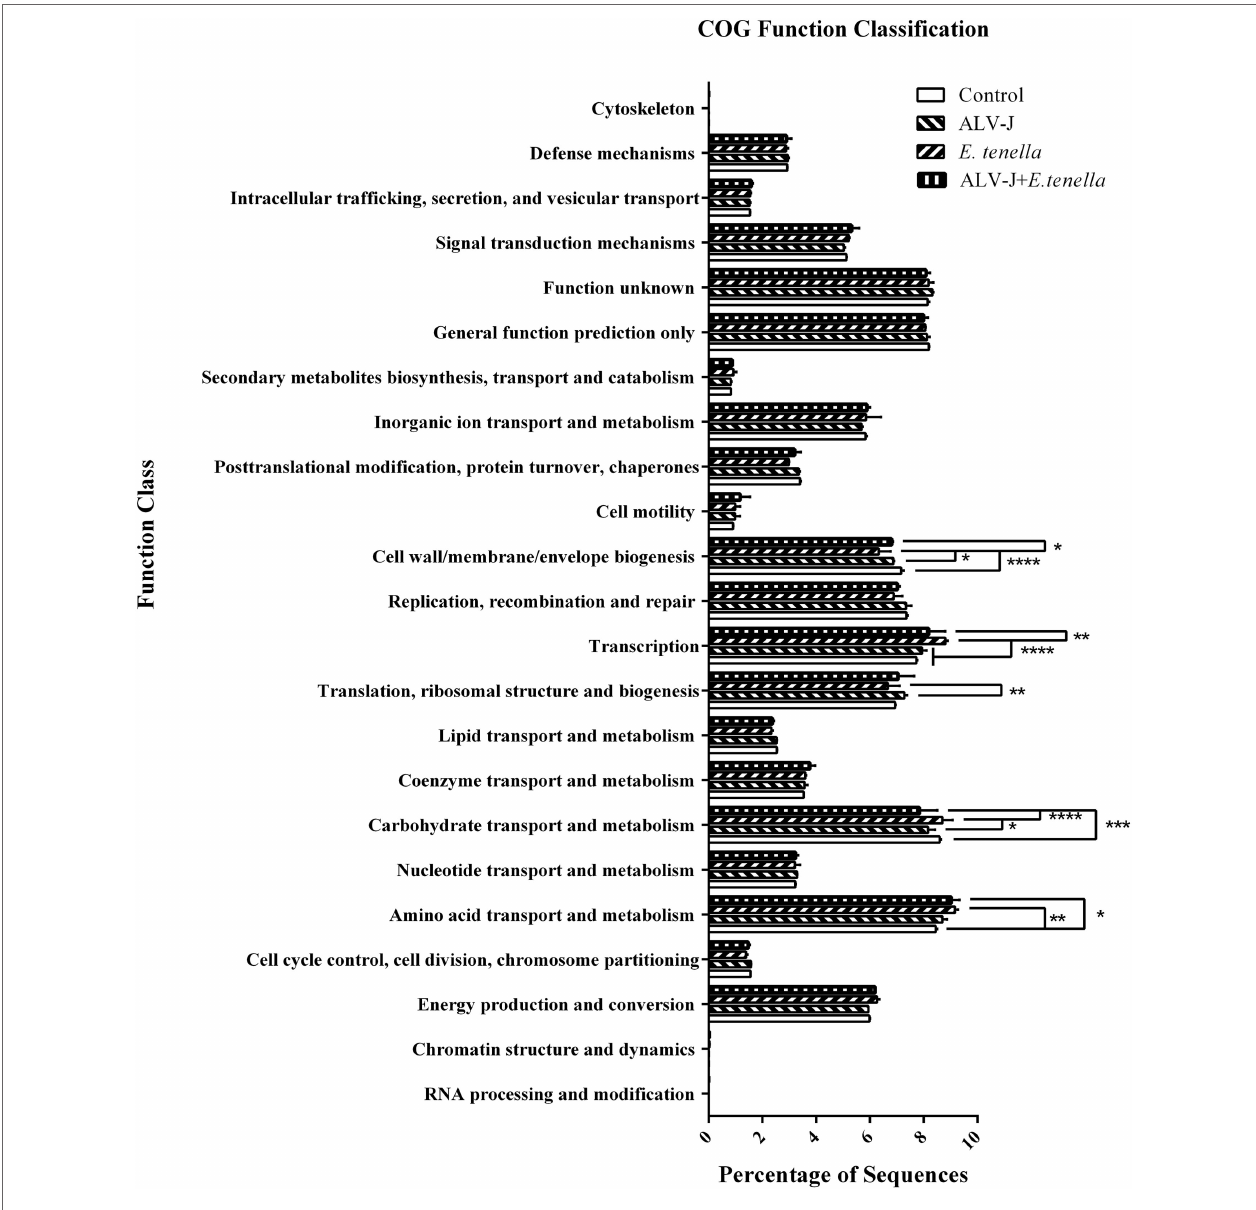
FigUre 5 | Function abundance profile of cecal microbiota of different groups. COG, clusters of orthologous groups of proteins. Error bars represent SDs. *Statistically significant difference between groups ( p <